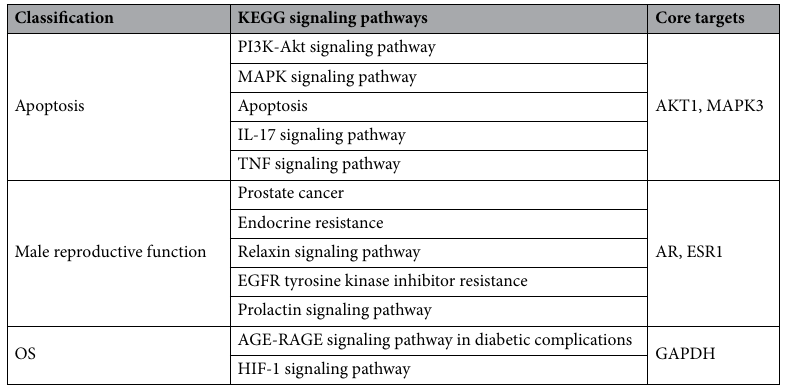
Table 1. Main KEGG signaling pathways and represent core targets.